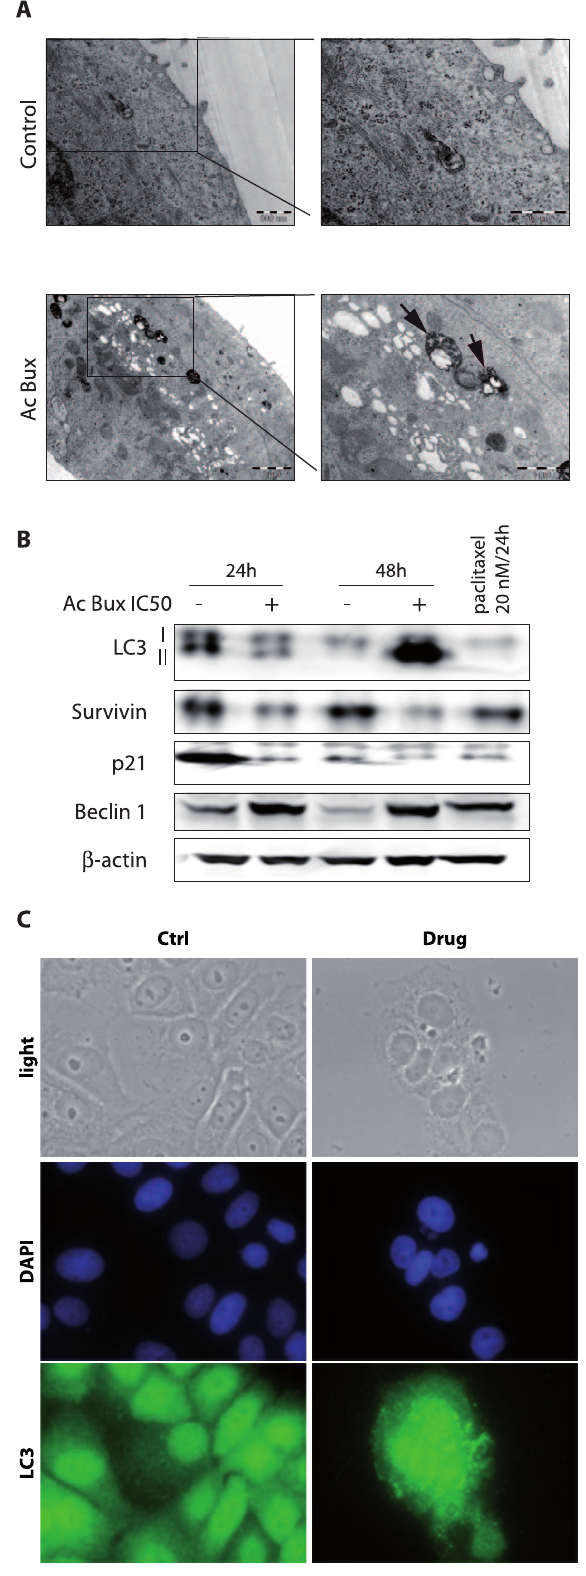
Figure 4. Acetonic extract of Buxus induces autophagy in MCF7 cell line. A. Transmission electron microscopy pictures of untreated and Buxus extract-treated MCF7 cells with IC 50 concentration for 72 h. Black arrows show degradative autophagic vesicles. White arrows